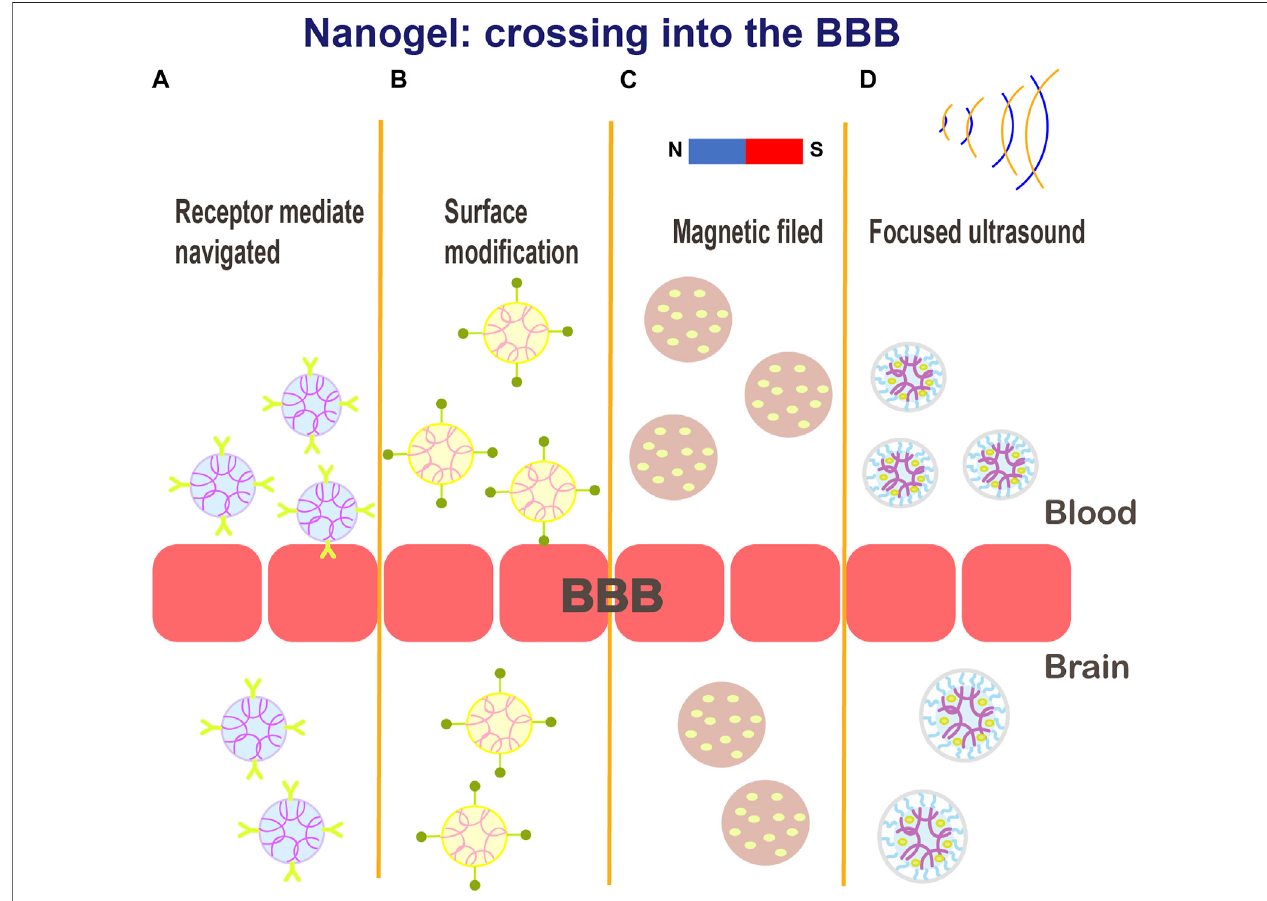
FIGURE 5 | Schematic illustration of the various potential mechanisms for crossing the BBB: (A) receptor-mediated endocytosis; (B) functionalized ligands that recognize cognate receptors on target organs or tissues; (C – D) magnetic fi eld or ultrasound mediated delivery.